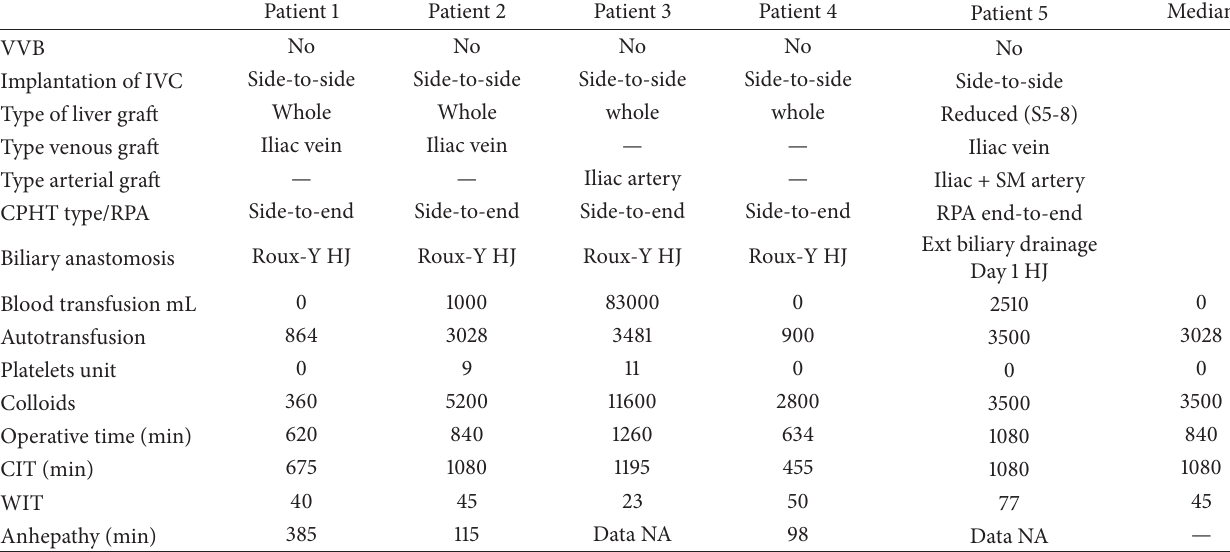
Table 2: Transplant procedure data.